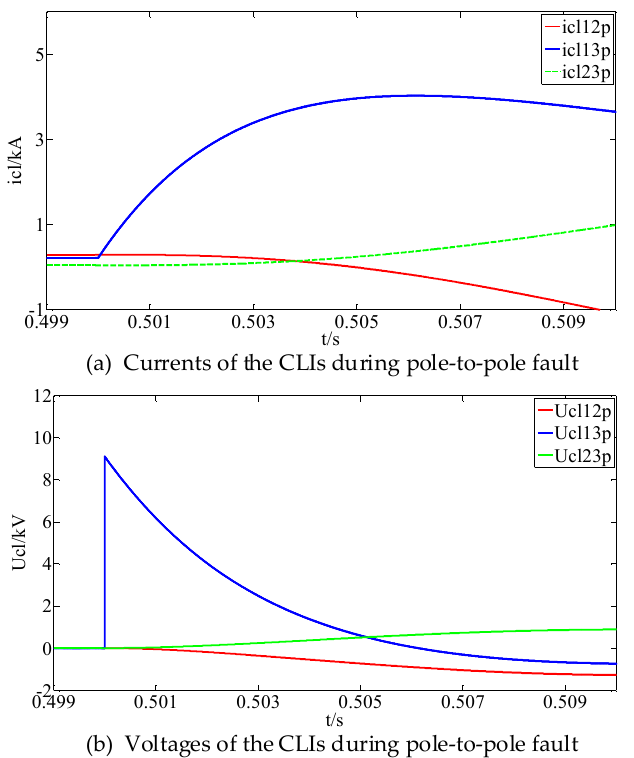
The pole-to-pole fault is applied at 0.5 s at the fault position F1. The currents and voltages of the CLIs after the fault are shown in Figure 15.